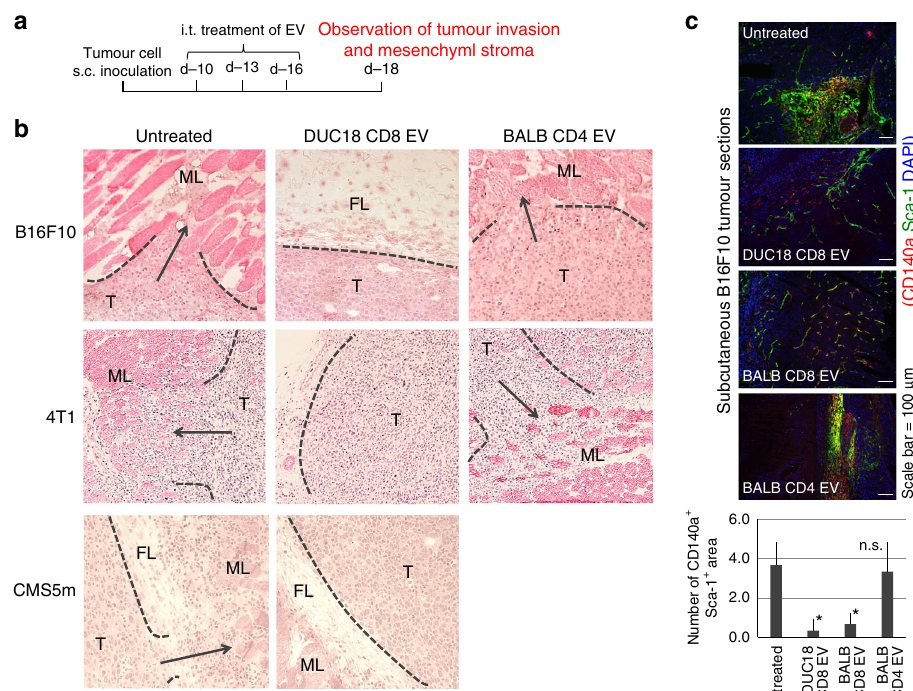
Fig. 4 Inhibition of tumour invasion by i.t. treatment of CD8 + T cell EVs. a Time schedule of the observation of subcutaneous tumour invasion. At days 10, 13 and 16 after subcutaneous B16F10, 4T1 or CMS5m inoculation, DUC18 CD8 EVs, BALB CD8 EVs or BALB CD4 EVs were injected intratumorally (10 μ g [5 – 7 × 10 8 vesicles]/tumour/day). b B16F10, 4T1 or CMS5m tumours on day 18 were sectioned and stained with haematoxylin and eosin (T tumour area, ML muscle layer, FL fatty layer). c B16F10 tumours on day 18 were sectioned and stained with PE-CD140a and FITC-Sca-1-speci fi c mAbs and DAPI. Each photo is a representative of 3 – 4 photos of each group. The number of overlapping areas of PE and FITC fl uorescence of DUC18 CD8 EV and BALB CD8 EV- treated groups (*) were signi fi cantly different from the untreated group ( n = 7) with p < 0.05. The data were analysed by a two-tailed unpaired Student t - test. n.s. not signi fi cant